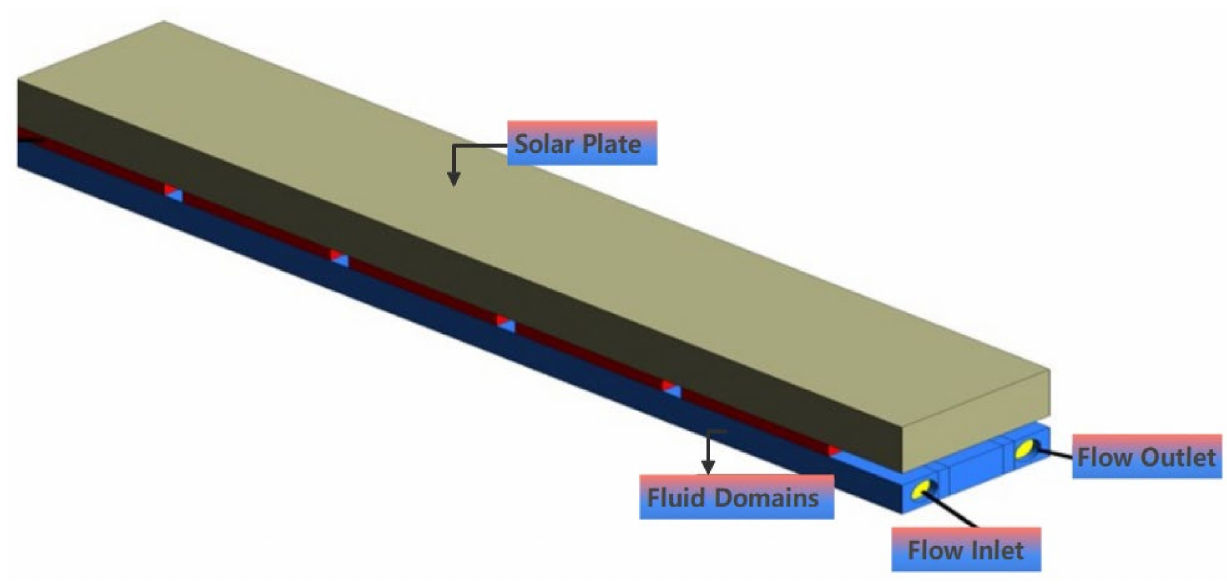
Figure 2. The geometry of proposed design.